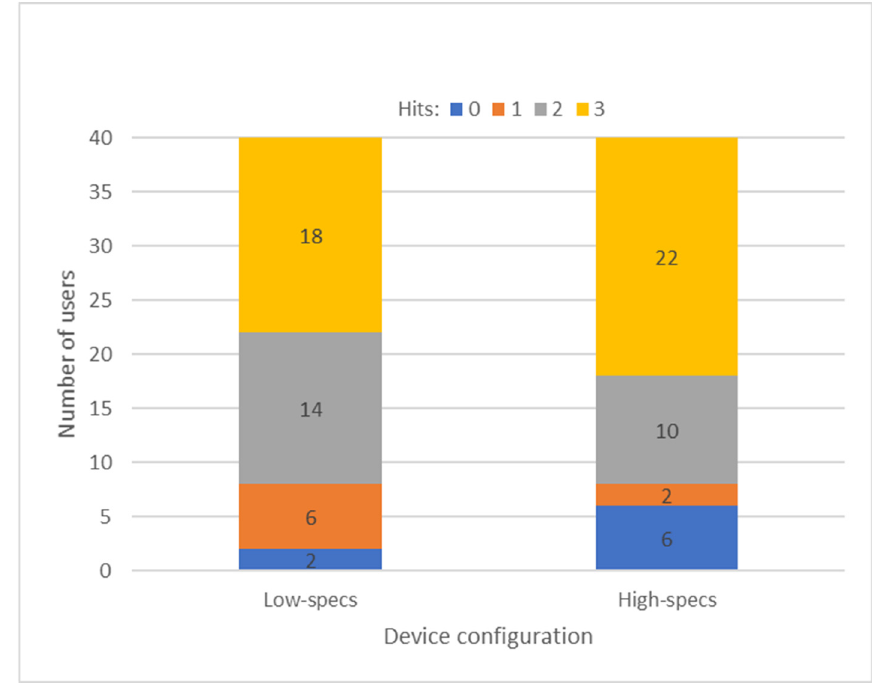
Figure 7. Number of successful AR annotations for each user.